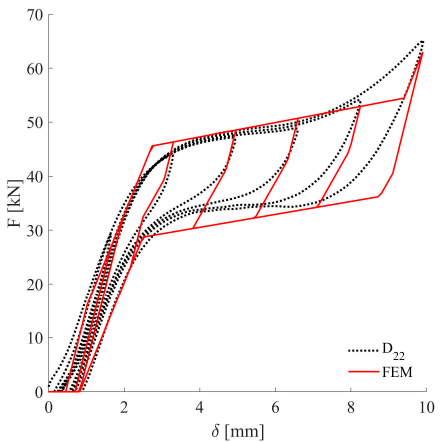
Figure 16. Comparison between the proposed hysteretic model and dynamic cyclic tests.